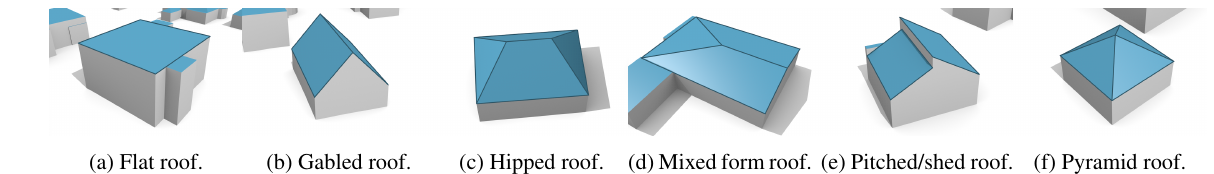
Figure 2. The six types of roofs (i.e. classes) in our study dataset.